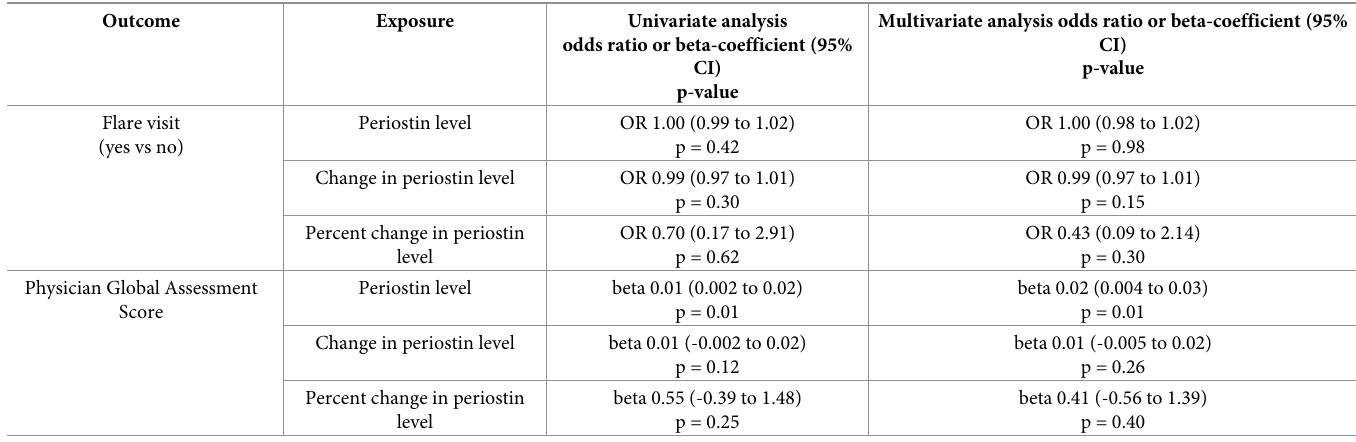
Multivariate analyses adjusted for ANCA type (ever positive or not), active asthma in the past 28 days, current prednisone use, and current use of other immunosuppressive therapies; for all analyses except percent change in periostin level, baseline periostin also included in model. CI, confidence interval. OR, odds